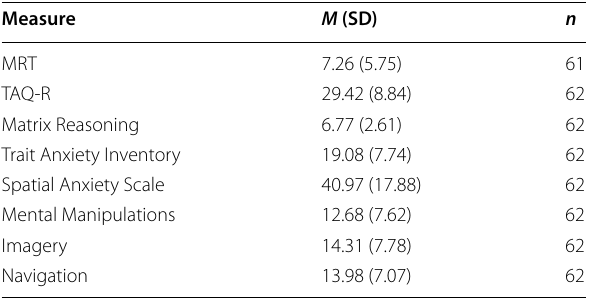
Mental Manipulations, Imagery, and Navigation are all subscales of the Spatial anxiety Scale